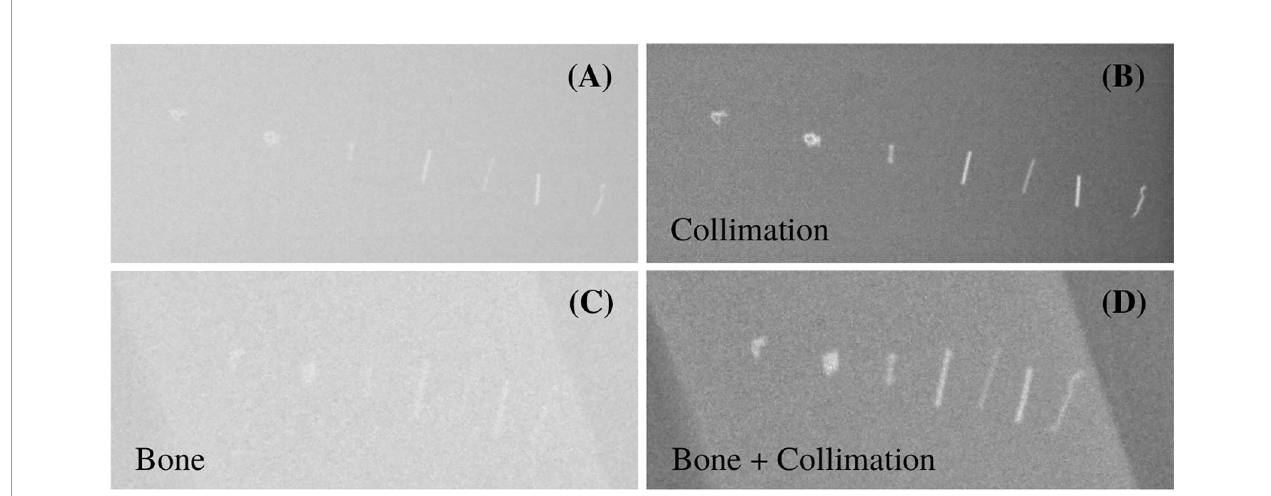
FIGURE 5 | X-ray images of 7 different fi ducial markers for the different settings described in Table 2 . From left to right: Gold Anchor (6), Gold Anchor (7), ZrO 2 (8), Viscoil (2), Visicoil (3), Visicoil (4), and Visicoil (1), listed in Table 1 . (A, B) show the images without and with collimation. (C, D) show the images with the bone slabs in front of the markers without and with collimation, respectively.